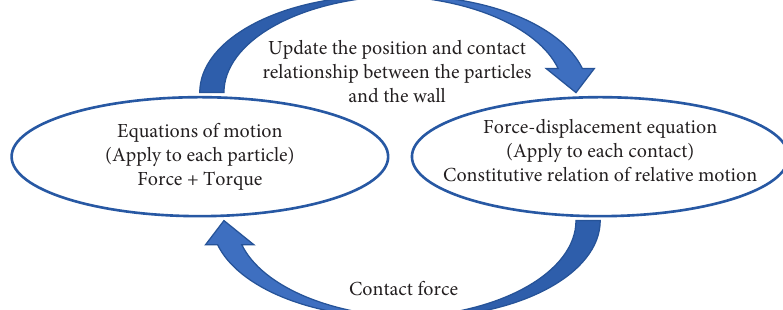
Figure 1: Calculation cycle process of PFC2D.